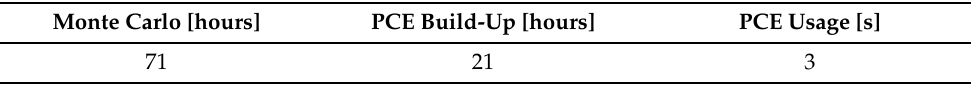
Table 8. Computational time needed to: perform a Monte Carlo analysis consisting of 10 3 samples; obtain 300 samples to construct the PCE surrogate, and emulate 10 4 samples using PCE. Monte Carlo [hours]